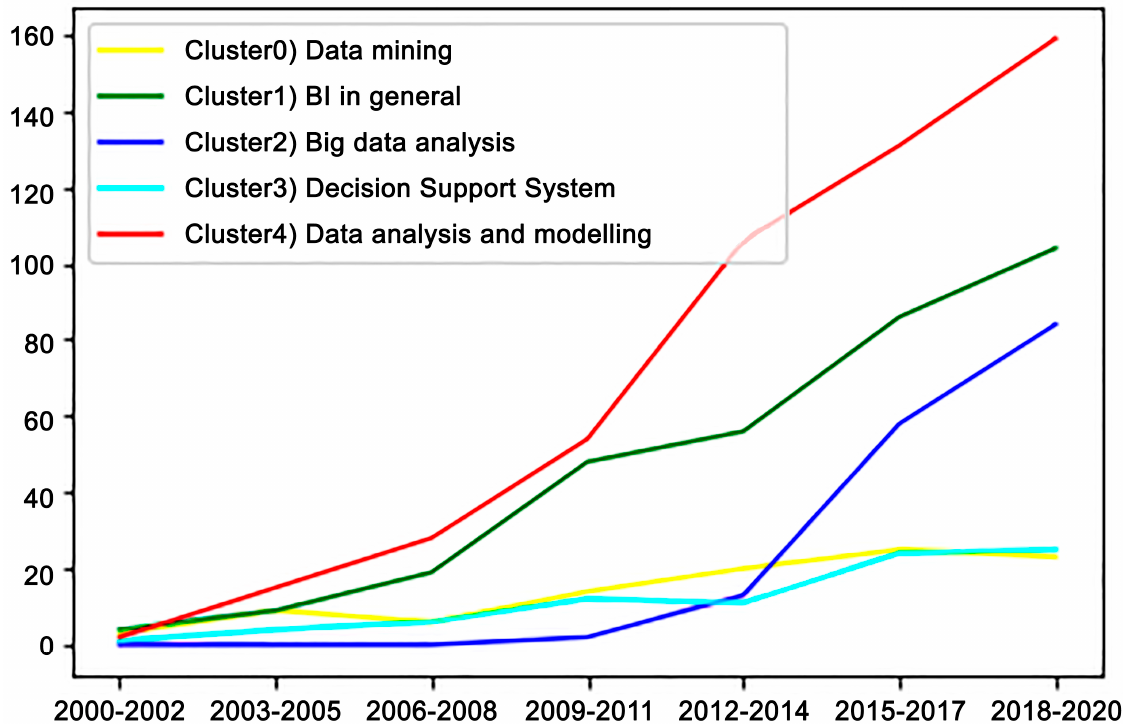
Figure 17. Graph of the distribution of all the clusters (five article groups) over time. Clusters 0 and 3 can also be observed. Cluster 0, which corresponds to data mining, shows moderately increasing interest from 2000 to 2015, and remains steady will the cur- rent date. In turn, cluster 3 is associated with decision support systems, showing moderate variations in the pattern of behavior with respect to interest between 2000–2015 and then remaining stable. 6. Discussion We aimed to shed light on the scientific production carried out over the last 20 years in BI&A associated with the concepts of strategic leadership competencies, with the ob- jective of understanding the development of this field of research and all those skills nec- essary for professionals who exercise organizational management with BI&A in order to create competitive advantages during the decision-making process. For this reason, a metric analysis was developed, in which a search protocol was ap- plied and information was retrieved from the world’s most recognized multi-disciplinary database platforms, Web of Science (WoS) Core Collection and Scopus, without a time restriction. The analysis corresponding to the informetric methodological stage (Stage 1) focused on metrics associated with scientific activity, i.e., scientific collaboration, structural analy- sis and thematic structure. Indeed, the results of scientific activity according to document typology show that the three document typologies analyzed were reviews, articles and conferences. The latter two have each shown an upward trend over the last 20 years of